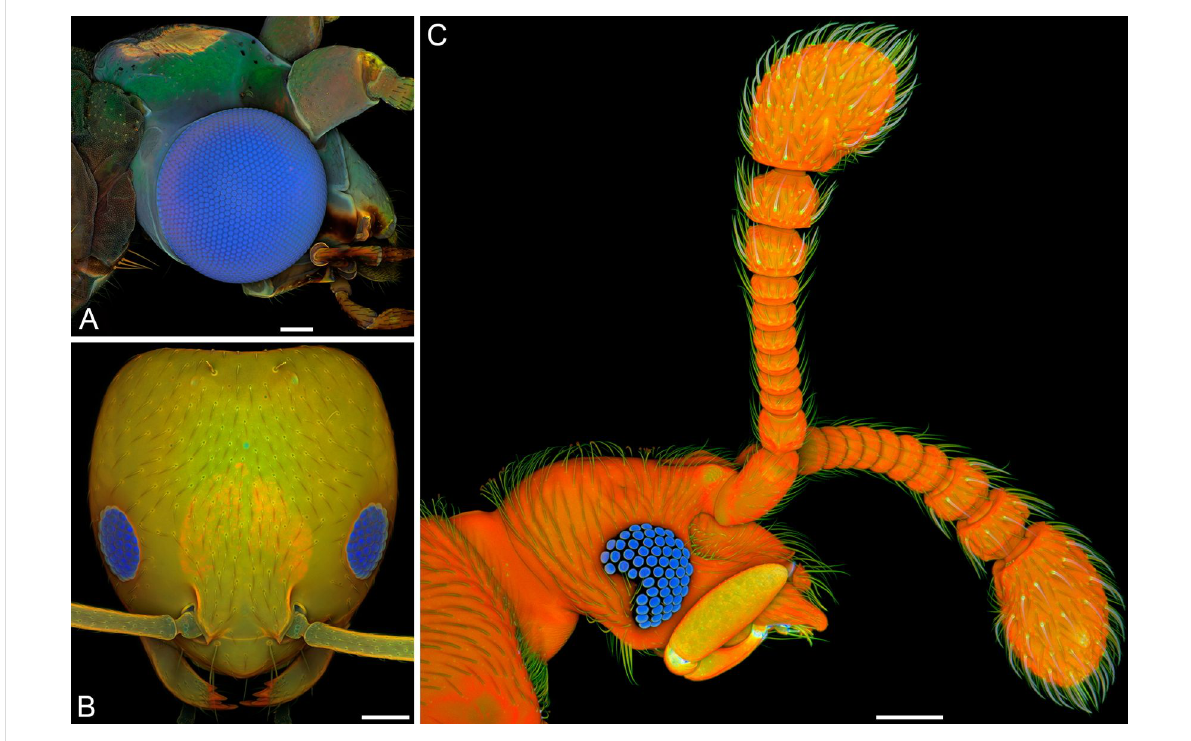
Figure 10: Resilin in compound eyes. Confocal laser scanning micrographs (maximum intensity projections) depicting overlays of different autofluor- escences exhibited by the exoskeleton. Blue structures contain large proportions of resilin. (A) Lateral view of the head of a male green lacewing ( Chrysoperla carnea ). (B) Frontal view of the head of a pharaoh ant ( Monomorium pharaonis ) worker. (C) Lateral view of the head of a beetle of the genus Circocerus . Scale bars = 100 µm (A, C), 50 µm (B). (A, B) Adapted with permission from [10], copyright 2011 John Wiley and